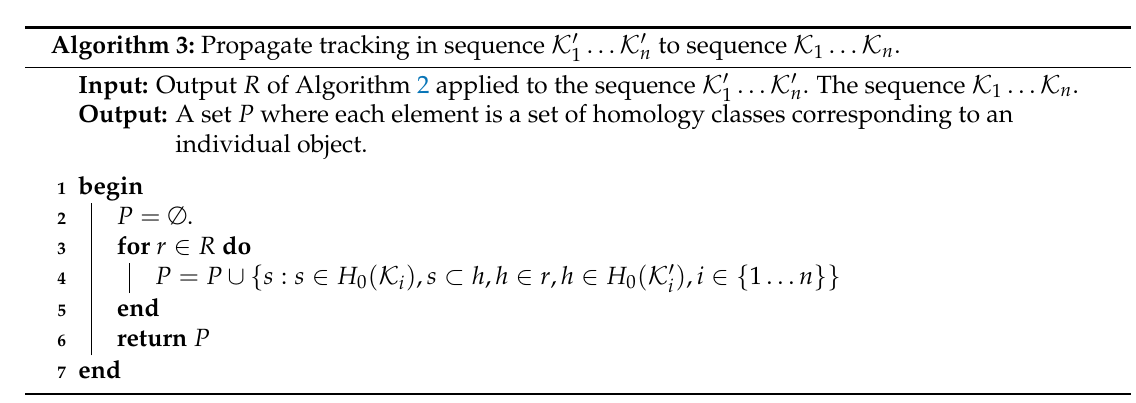
Algorithm 3: Propagate tracking in sequence K (cid:48)